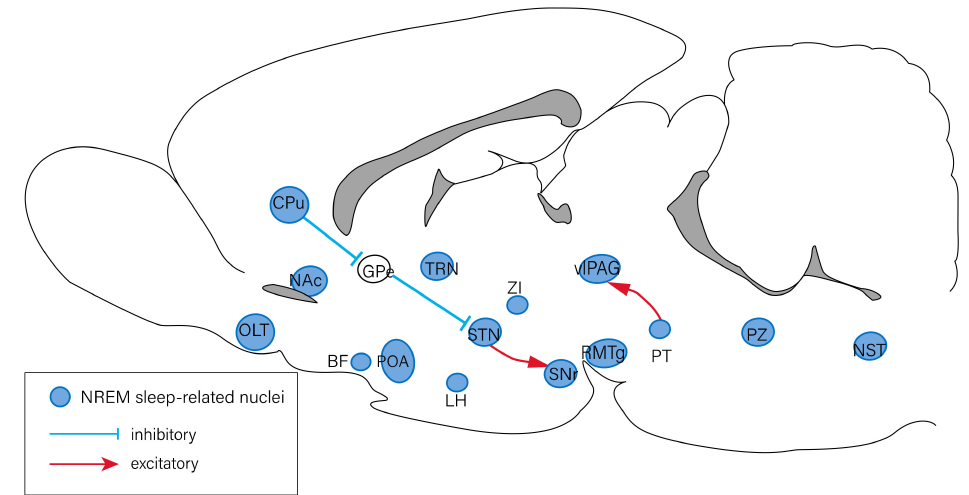
Figure 2. Neural circuits of NREM sleep regulation. The nuclei involved in the regulation of NREM sleep include the OLT, CPu, NAc, GPe, BF, POA, TRN, LH, STN, ZI, SNr, RMTg, vlPAG, PT, PZ, and NST. The PT has an excitatory projection to the vlPAG, and the CPu inhibits the STN neurons by suppressing the GPe. The STN has an excitatory projection to the SNr. BF: basal forebrain; CPu: caudate putamen; GPe: external globus pallidus; LH: lateral hypothalamus; NAc: nucleus accumbens; NST: nucleus of solitary tract; OLT: olfactory tubercles; POA: preoptic area; PT: pontine tegmentum; PZ: parafacial zone; RMTg: rostromedial tegmental nucleus; SNr: subtantia nigra pars reticulata; STN: subthalamic nucleus; TRN: thalamic reticular nucleus; vlPAG: ventrolateral periaqueductal gray; ZI: zona incerta.